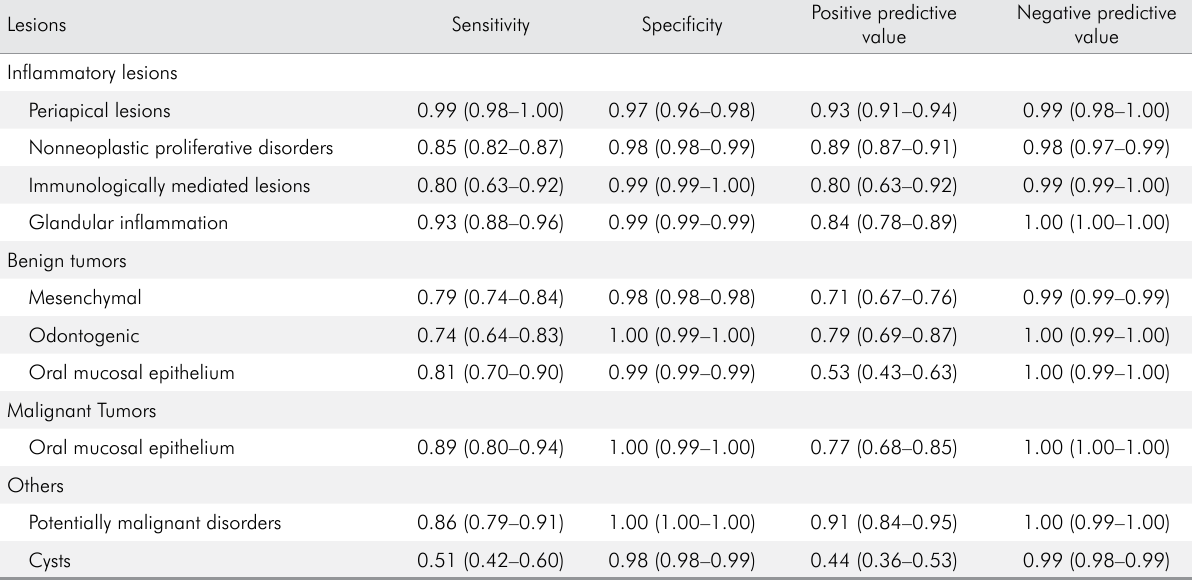
Table 2. Diagnostic tests for each type of